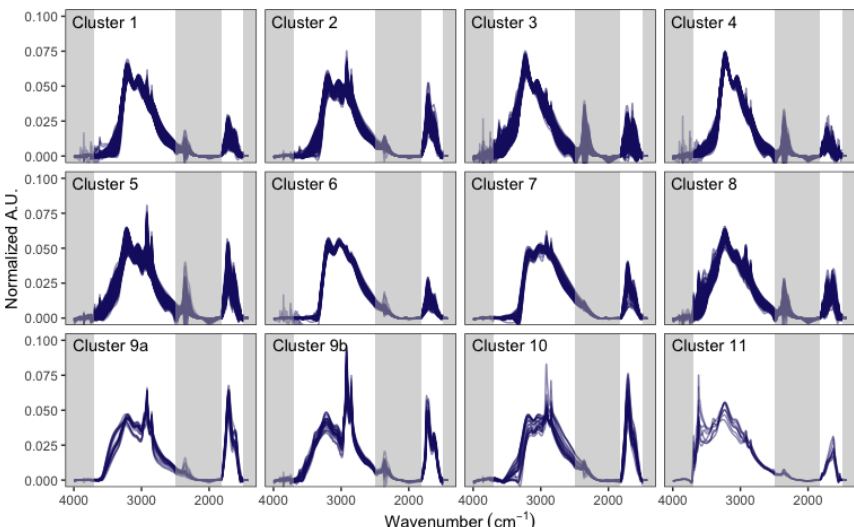
Figure 4. Visualization of spectral clusters. Vertical gray bars indicate regions excluded from cluster analysis. The clustering procedure and interpretation are described in Sects. 3.1 and 4.2,